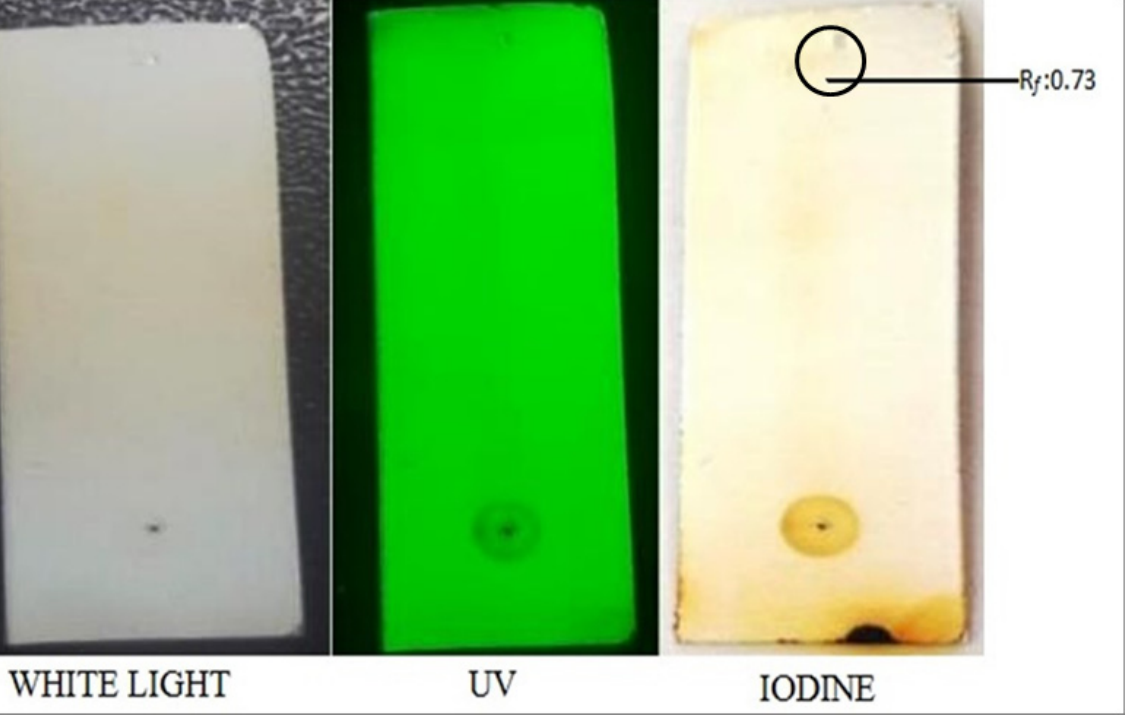
Figure 3. Thin-layer chromatography of the purified compound from the extracts of Leucas indica flowers.